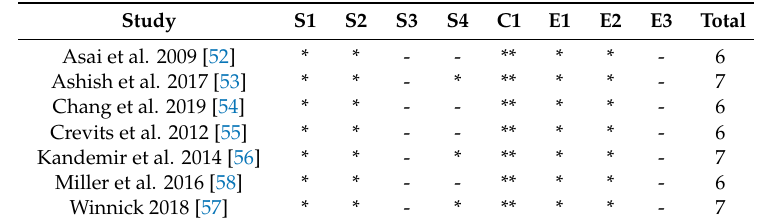
Newcastle–Ottawa Scale (NOS) score for the methodological quality assessment of included